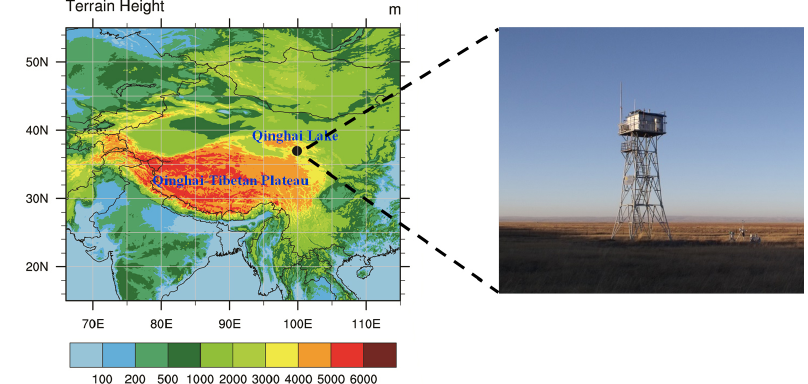
Figure 1. Left: geographical location of the Qinghai–Tibetan Plateau and surrounding areas. The color code represents topographical features (unit: m). Right: observation tower at the “Bird Island” peninsula in Qinghai Lake,